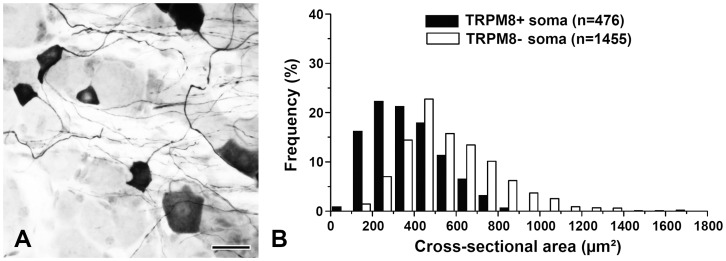
Light micrograph showing TRPM8+ neurons in the trigeminal ganglion and their size distribution.(A, B) The TRPM8+ neurons are mostly small and medium sized. Scale bar  = 25 μm.